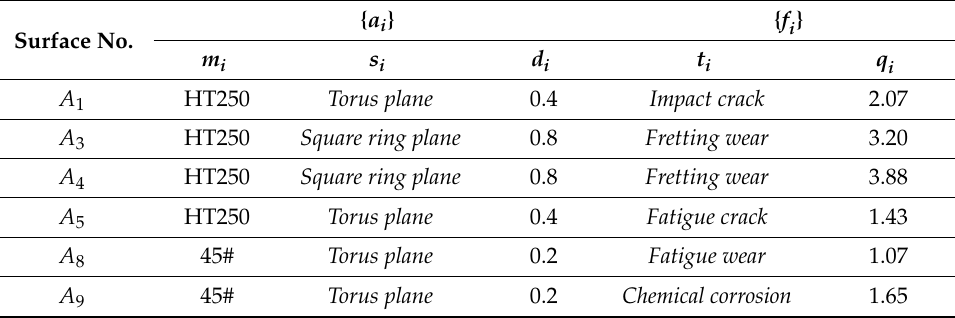
Table 3. The feasible process plans of surface A 1 . Case